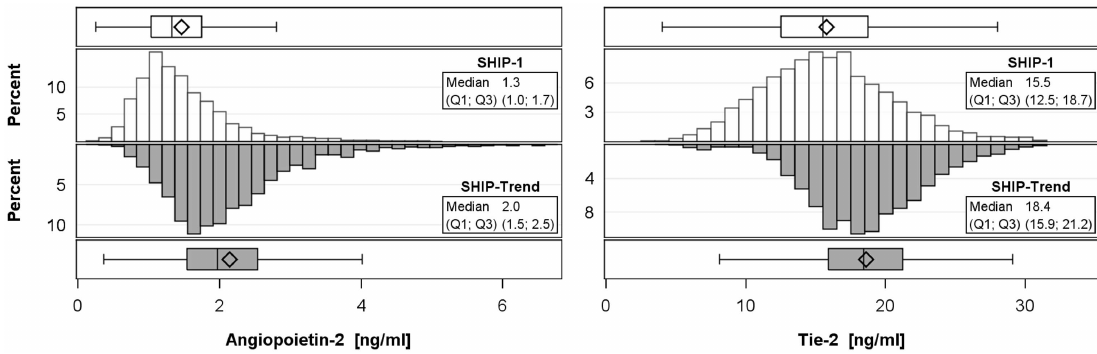
Fig 1. Histograms and boxplots of serum angiopoietin-2 and Tie-2 receptorconcentrations by study sample (SHIP-1 and